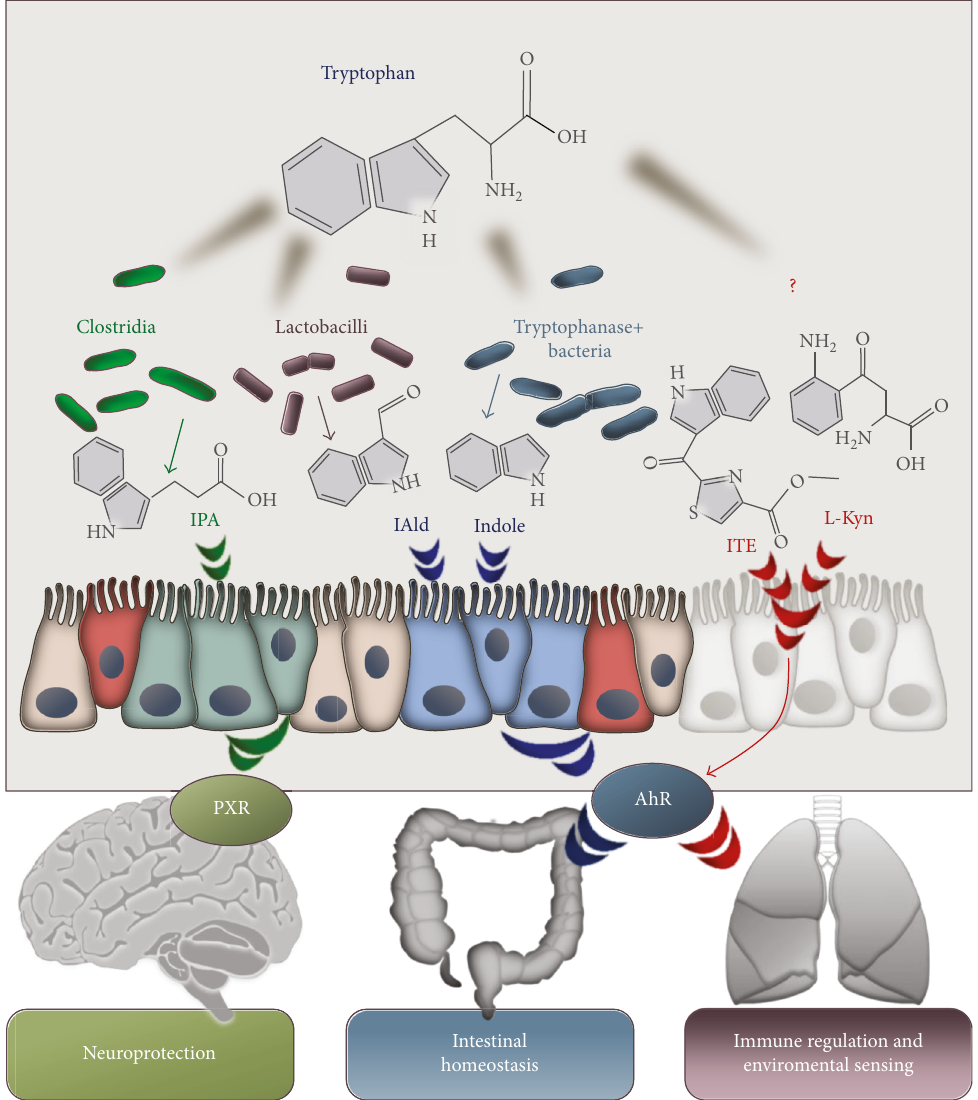
Figure 1: Tryptophan degradation pathways. The image shows how di ff erent microbes are involved in several pathways of tryptophan degradation leading to the production of immunoreactive metabolites acting locally and systemically as agonists of PXR and AhR. IPA: indole-3-pyruvic acid; IAld: indole-3-aldheyde; ITE: 2-(1H-indol-3-ylcarbonyl)-4-thiazol carboxylic acid methyl ester; L-Kyn: L- Kynurenine; PXR: pregnane X receptor; AhR: aryl hydrocarbon